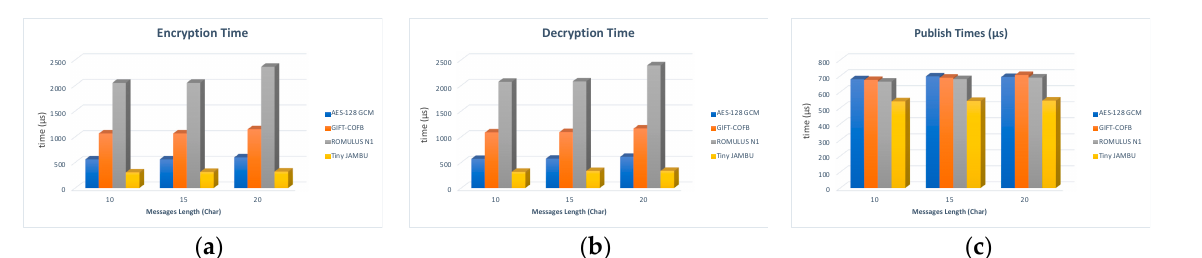
Figure 7. Lightweight Cryptographic Performance on NodeMCU on WiFi Network Used Registered